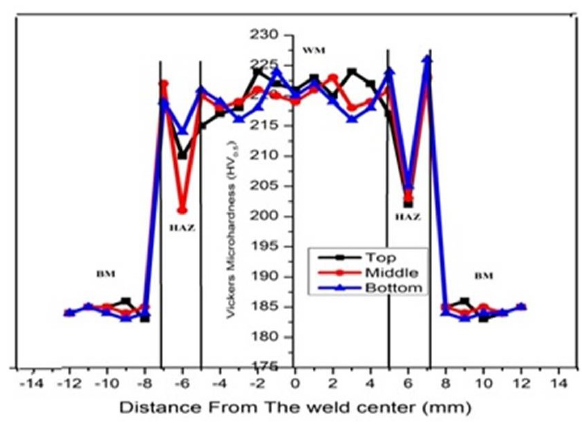
Figure 13: Microhardness for weld joint.